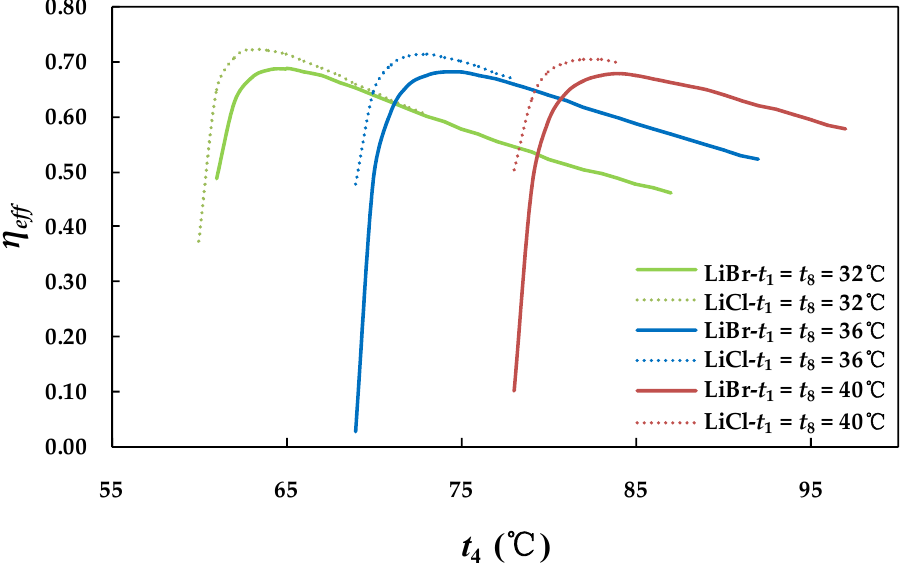
Figure 4. Generator temperature impact on the efficiency ratio of absorption system under various condenser and absorber temperature levels (32 °C, 36 °C, and 40 °C) for the two working pairs (t 10 = 7 °C, ε = 0.7).